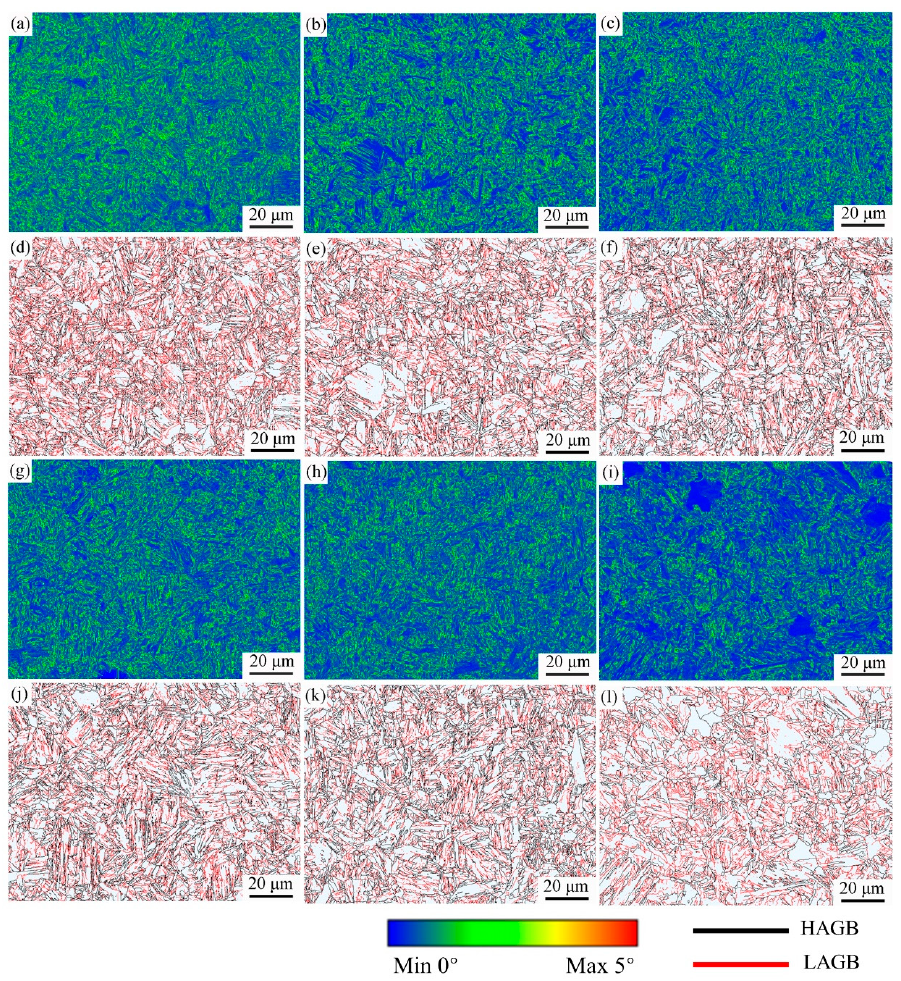
Figure 8. Kernel average maps and grain boundary distribution maps of the specimens after different heat treatments. ( a , d ) WQ, ( b , e ) QT400, ( c , f ) QT450, ( g , j ) QT500, ( h , k ) QT550, ( i , l ) QT600.